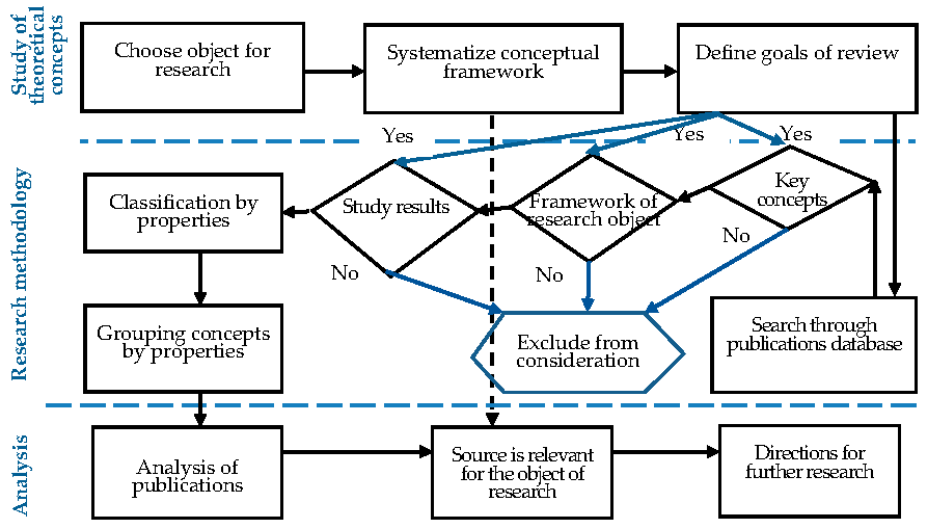
Figure 1. The methodology of the research.